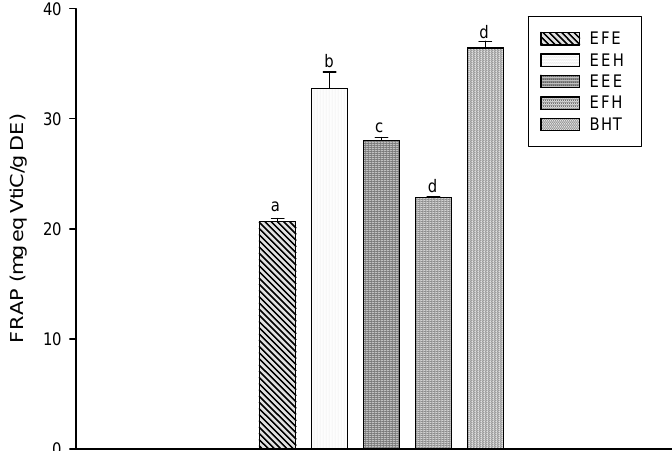
Figure 6. Ferric reducing antioxidant power (FRAP) antioxidant activities of the different plant extracts. Values are expressed as mean ± SD of three replicates. The values labeled with different letters differ significantly different at p < 0.05. EEE: H. zenkeri ( bark) ethanolic extract; EFE: H. zenkeri (leaves) ethanolic extract; EEH: H. zenkeri (bark) hydro-ethanolic extract; EFH: H. zenkeri (leaves) hydro-ethanolic extract; BHT: butylated hydroxyl